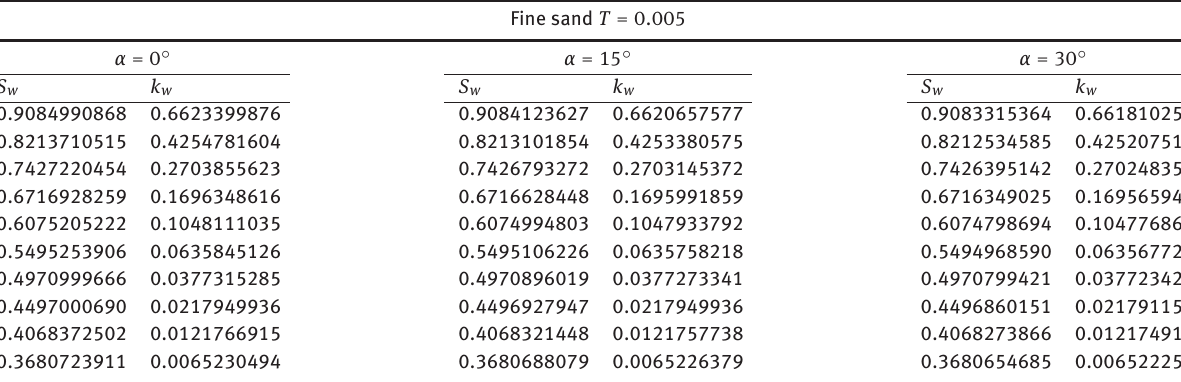
Table 8: Comparison of the numerical values for saturation vs. permeability in heterogeneous porous media for fine sand at different in- clined plane α = 0 ◦ , 15 ◦ , 30